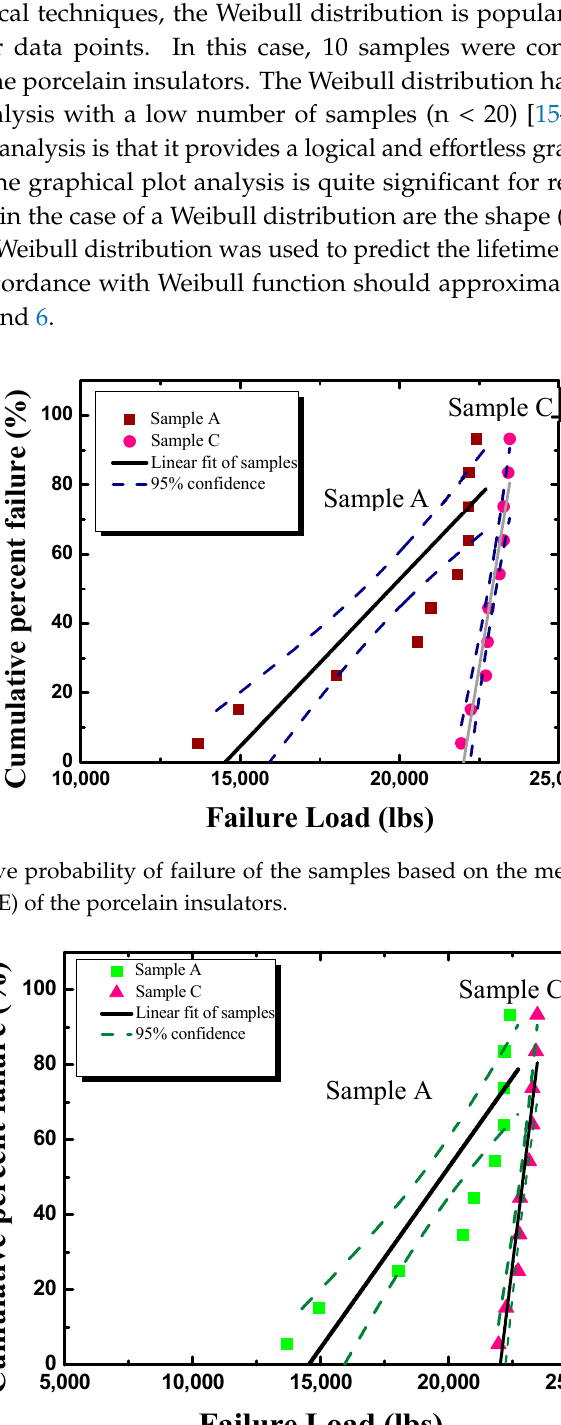
Figure 4. Microstructure of insulator sample A depicting a high porosity of the porcelain body.